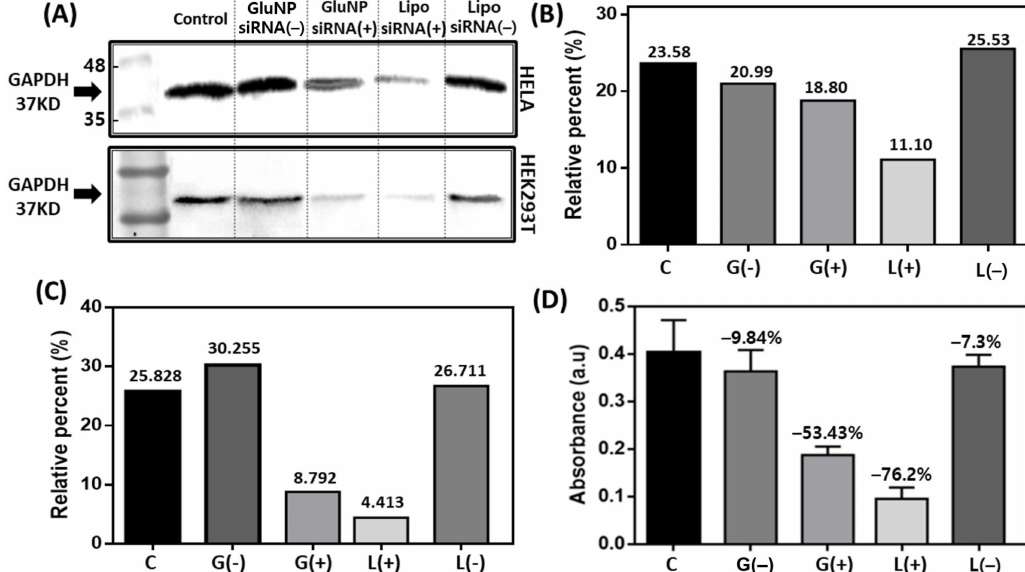
Figure 5. Delivery of siRNA using the β -glucan nanoparticles (GluNPs) to modulate the expression of glyceraldehyde 3-phosphate dehydrogenase (GAPDH). ( A ) Western blot results confirming the decreased expression of GAPDH in the HeLa and HEK293T cells treated with siRNA( − ), siRNA / GluNP( − ), siRNA / GluNP( + ), Lipo (Lipofectamine) / siRNA( + ), and Lipo / siRNA( − ). Scrambled siRNA as the negative control ( − ). The positive control ( + ) siRNA could only knockdown the target gene GAPDH. Relative expression of GAPDH by ( B ) HeLa cells and ( C ) HEK293T cells plotted using Image J software to indicate the percentage of GAPDH expression area that is relative to the selected area including the five groups (double line of the box each cell). ( D ) Enzyme-linked immunosorbent assay (ELISA) of the lysed samples of HEK239T obtained from Western blot preparation confirmed the mRNA expression of GAPDH at the protein level. C, siRNA( − ); G( − ), siRNA / GluNP( − ); G( + ), siRNA / GluNP( + ); L( + ) Lipo / siRNA( + ); L( − ), Lipo / siRNA( − ). The data are presented as mean ± SEM of three independent